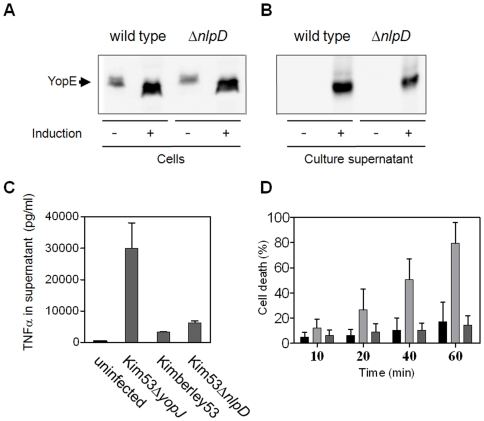
Analysis of TTSS activity and resistance to acidic pH of Y. pestis strains.To assay the functionality of the TTSS, wild type Kimberley53 and avirulent Kim53ΔnlpD strains were grown for 4 hours at inducing and non–inducing conditions (37°C±calcium). Western blot analyses of bacterial extracts (A) and culture supernatants (B) were performed with anti-YopE antibodies. (C) Suppression of TNF-α secretion from infected macrophages. RAW264.7 cells were infected by impaction with 100 MOI of Kimberley53, 50 MOI of Kim53ΔnlpD or 100 MOI of Kim53ΔyopJ. Secretion of TNF-α into the culture medium was monitored 2 h after initiation of infection by ELISA. (D) Resistance to acidic pH. Overnight cultures of Kimberley53 (black columns), Kim53ΔnlpD (dark gray columns) and Kim53ΔnlpD(pnlpD) (light gray columns) were used to inoculate HIB (initial OD660 = 0.1). These cultures were incubated at 37°C for 4 hours, washed with phosphate buffered saline and then exposed to acidic stress (pH 4.2) for the indicated time. Viable cell counts were determined by plating dilutions on BHI agar and incubating at 28°C for 48 hours.